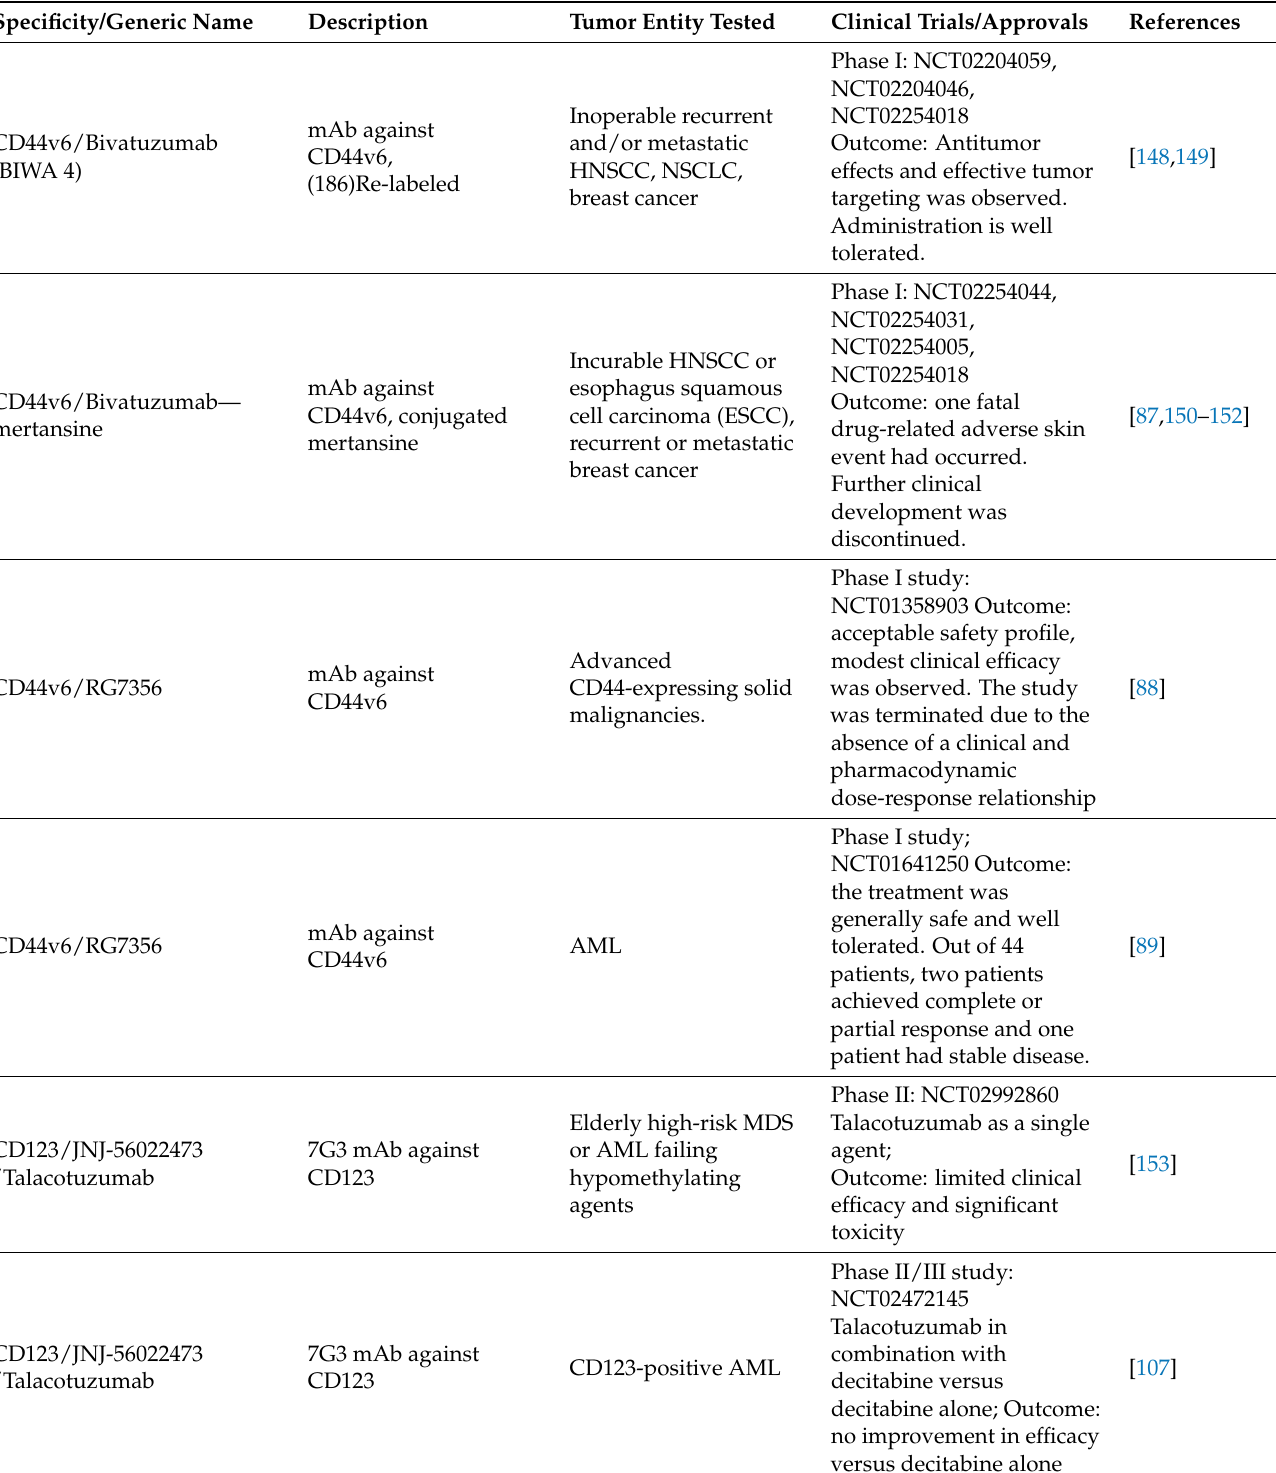
Table 1. Selected clinical trials for antibody-based therapies targeting tumor cells, including